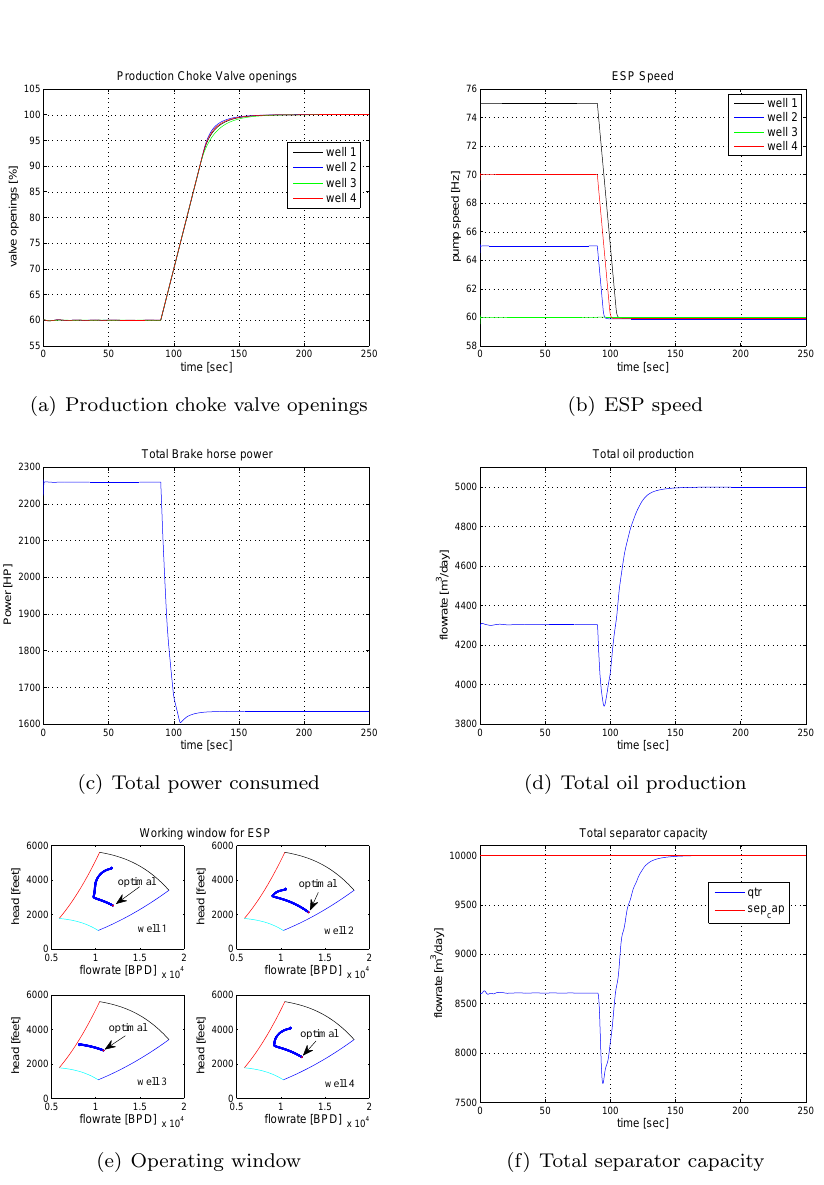
Figure 3: Optimal control of ESP oil field using two PI